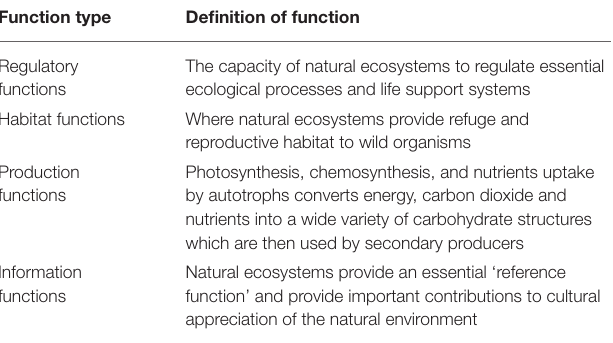
TABLE 4 | Types of ecosystem functions as defined by De Groot et al.